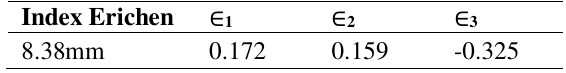
Values of principal strains in the bulge test.